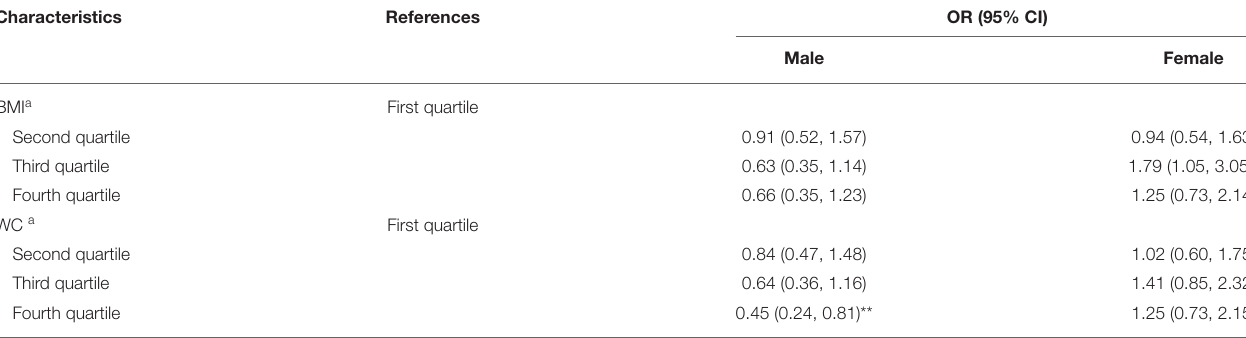
TABLE 5 | Association of BMI and waist circumference quartiles with cognitive impairment by sex in the multivariate analysis.